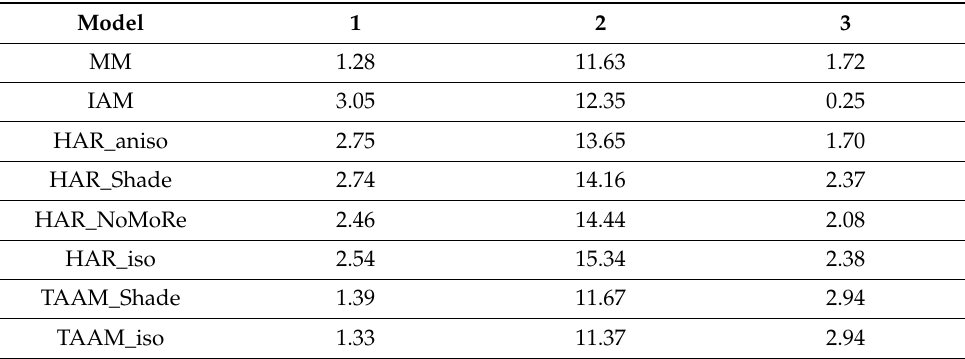
Table 2. Differences between lattice energies calculated based on the final models and the neutron data. Calculations for charge density models were performed without geometric optimization. Calculations for models obtained from neutron measurements were performed with geometric optimization. Results are shown in kJ/mol. Calculations were performed using CRYSTAL17 at the DFT/B3LYP level of theory and applying the DFT-D3(ATM) dispersion correction, using the cc-pVDZ basis set.